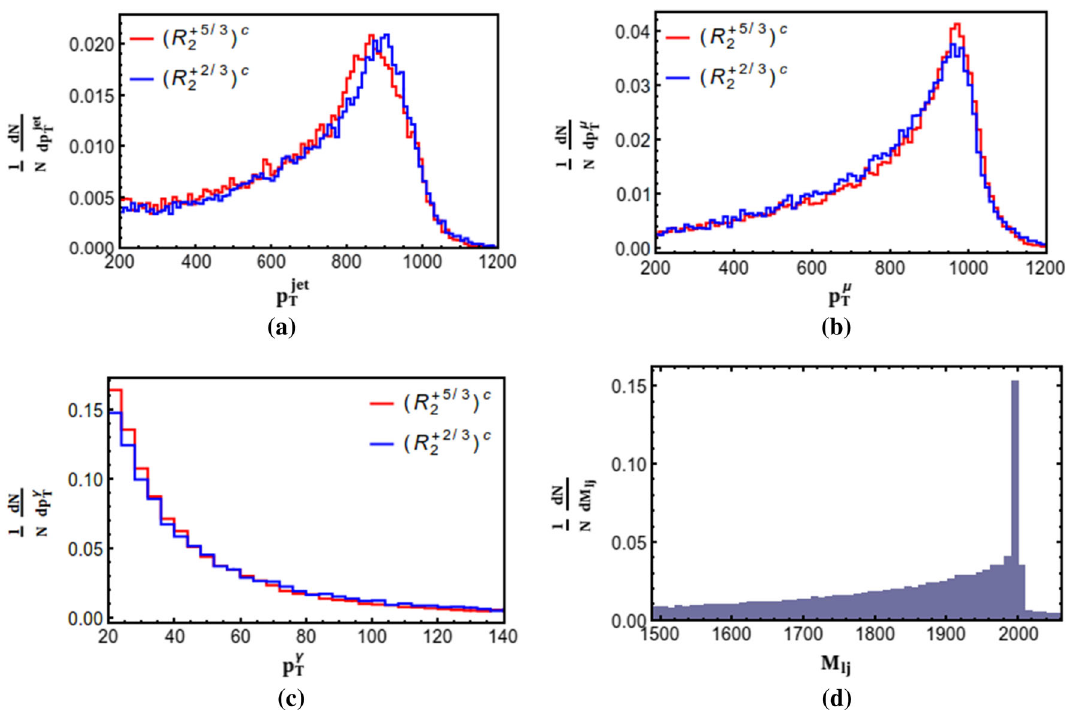
√ s = 3464 . 1 GeV for the scalar-doublet leptoquark R c